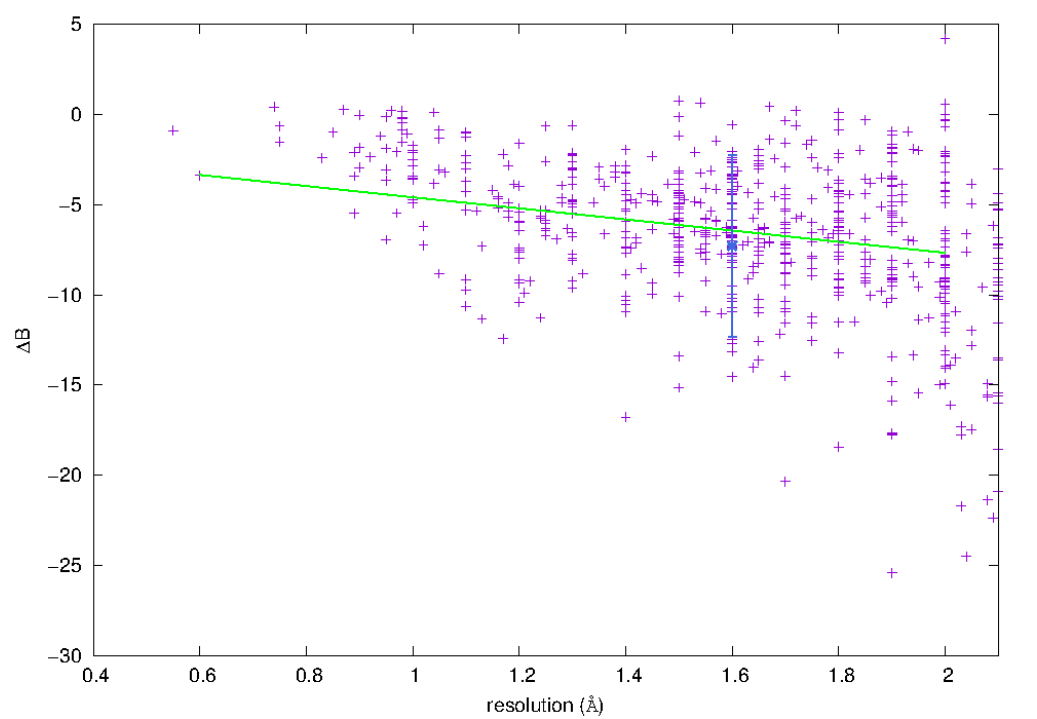
Figure 12. Values of ∆ B for 934 models of nucleic acid from the PDB plotted against reported resolution. The regression line is shown in green with the average value of ∆ B , -7.237 Å 2 , shown with the error bars in